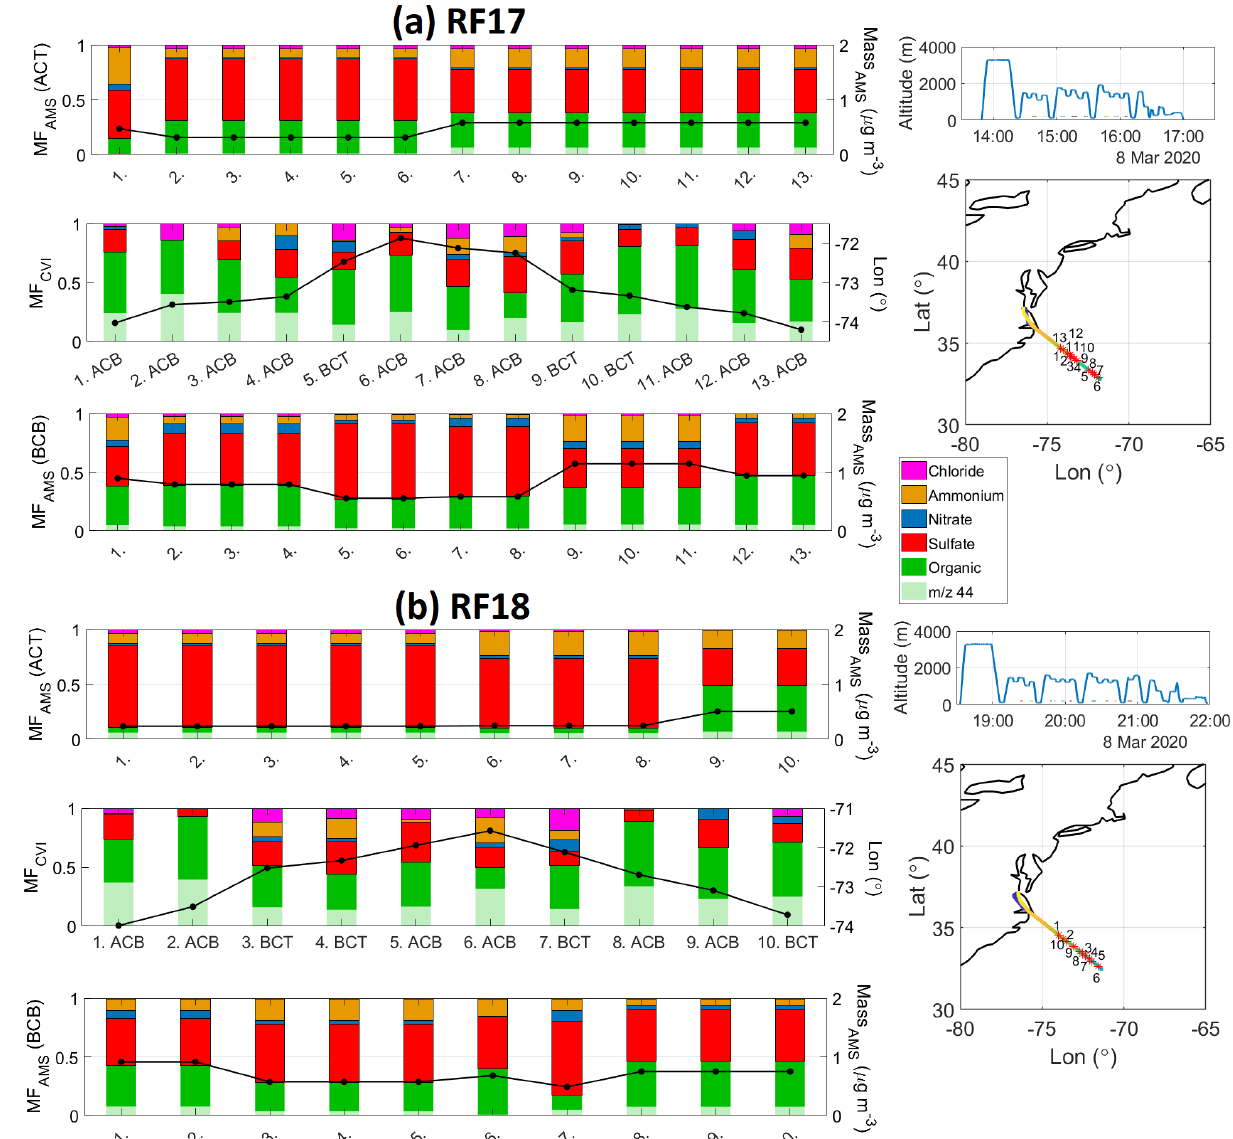
Figure 9. Summary of AMS composition in adjacent BCB, cloud, and ACT legs during back-to-back flights (research flights 17 and 18) in CAO conditions on 8 March 2020. Shown in the bar charts are the mass fractions of AMS components in addition to either total AMS mass (for ACT and BCB legs; such data are not robust for CVI legs due to how the CVI operates) or longitude on the right y axis. Note that some BCB and ACT legs are repeated for different cloud legs as they represent the closest leg to an individual cloud leg. On the far right are Falcon altitude during the flight along with the spatial map with numbers corresponding to the leg set numbers in the bar